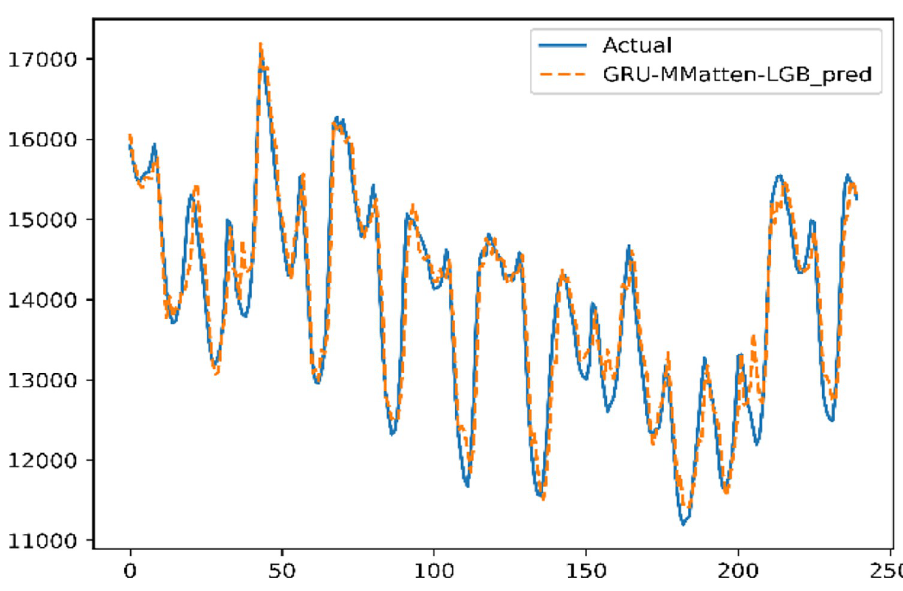
Fig 9. GRU-MMatten-LGB prediction